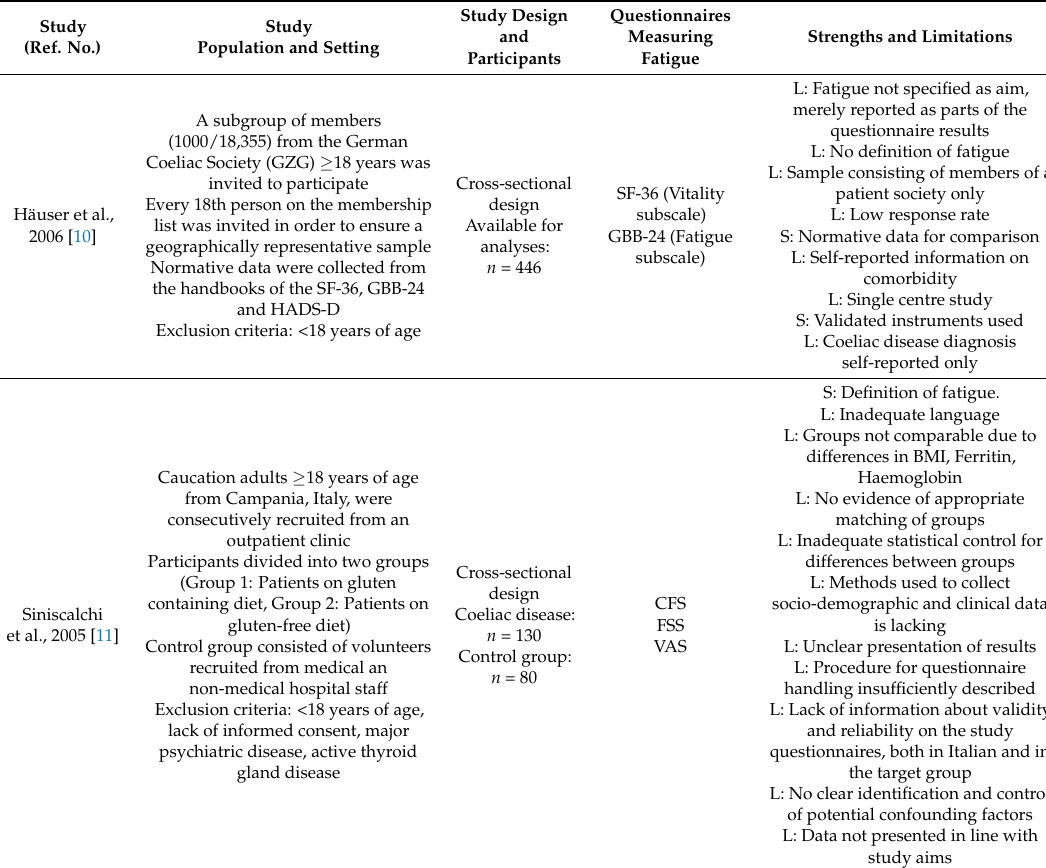
Table 2. Summary of the included